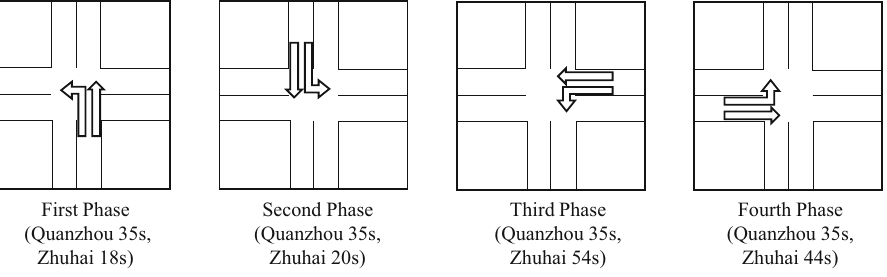
Fig. 6 Experimental phase schematic